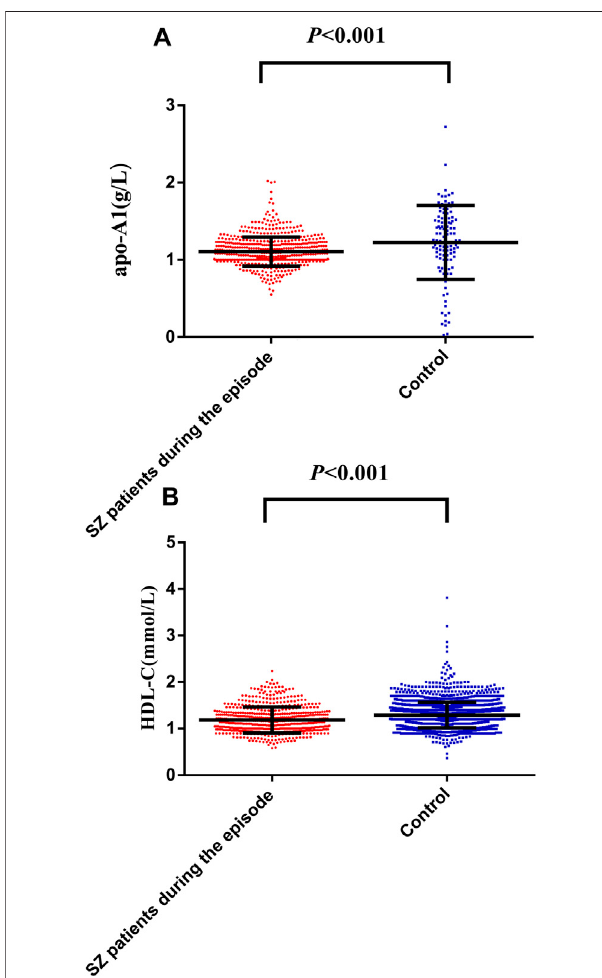
FIGURE 2 | Distribution of apoA1 (A) and HDL-C (B) levels between SZ patientsduringtheepisodeandcontrols.Thedotsrepresentindividualdataof apoA1 and HDL-C levels. The upper line and lower line represent 75th percentage and 25th percentage respectively, and the medium line represents the median. The serum apoA1 [median (IQR)] was signi fi cantly lower in SZ patients during the episode [1.07 (1.00.1.21) g/L] than controls [1.21 (0.88.1.51) g/L], Z (cid:2) 4.04, p < 0.001 ( Figure 2A ). Similarly, HDL-C level in SZ during the episode [1.14 (0.99.1.34) mmol/L] was lower than controls